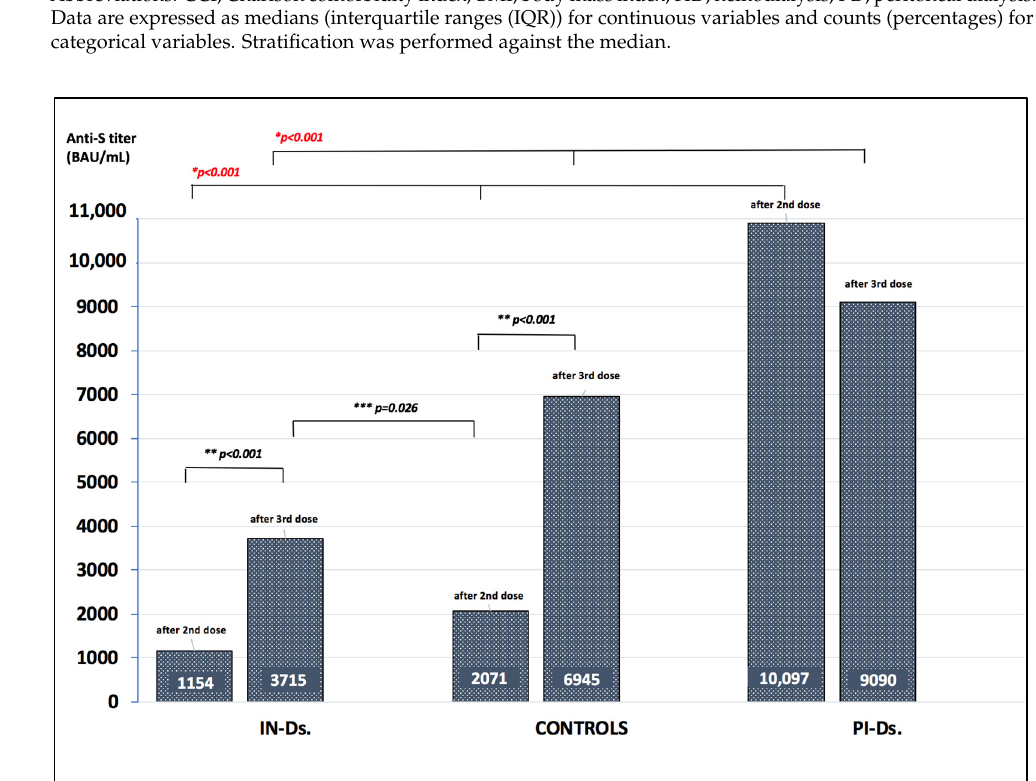
Figure 2. Anti-S antibody titer after the second and third dose of mRNA vaccine. * Kruskal–Wallis test: (IN-Ds vs. the controls vs. PI-Ds). Multiple range test for paired comparisons: after second dose, (IN-Ds vs. the controls: p = 0.002) and (IN-Ds vs. PI-Ds: p < 0.001); after third dose, (IN-Ds vs. PI-Ds: p = 0.001). Additional secondary analyses: ** p < 0.001 (IN-Ds’ second vs. IN-Ds’ third dose; controls’ second vs controls’ third dose). *** p = 0.026 (IN-Ds’ third dose vs. controls’ second dose).